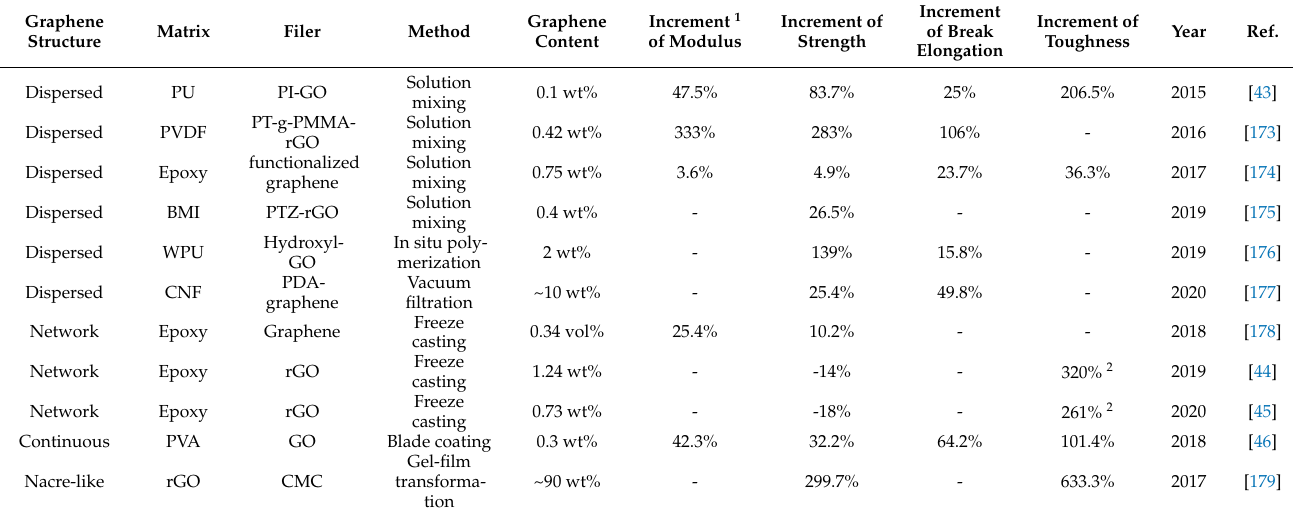
Table 3. Summary of up-to-date stiffening, strengthening, and toughening of graphene/polymer composites. Graphene